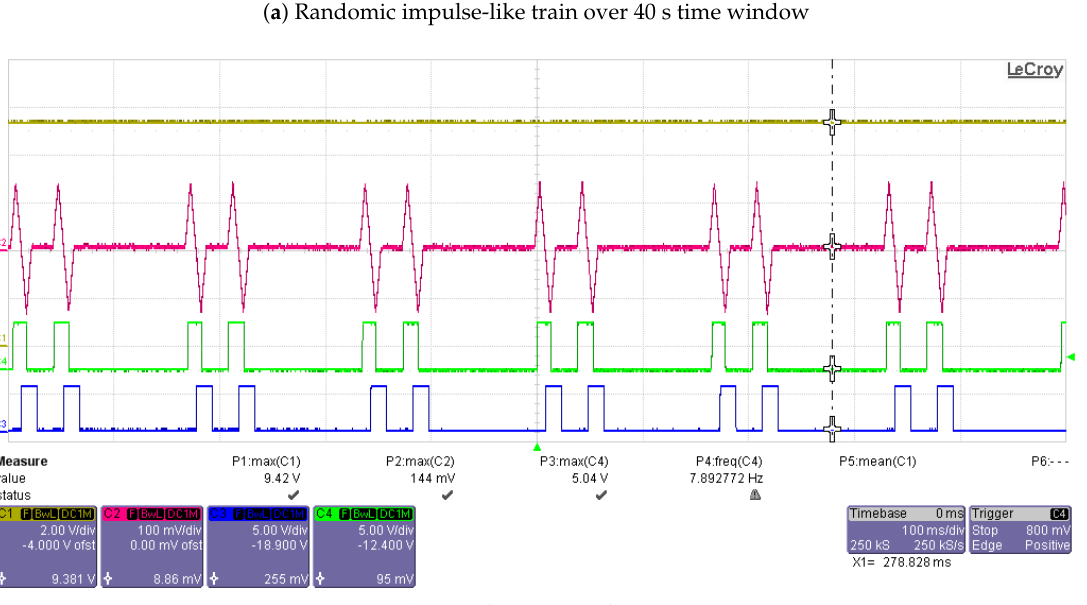
Figure 14. Oscilloscope screenshots of the measurements with impulse − like input voltage. Yellow line is the output (V out ), magenta line is the input voltage (V in ) while green and blue lines are PWM1 and PWM2 signals, respectively. Controllable parameters are D = 75% and T D = 1%, while R out = 1 M Ω